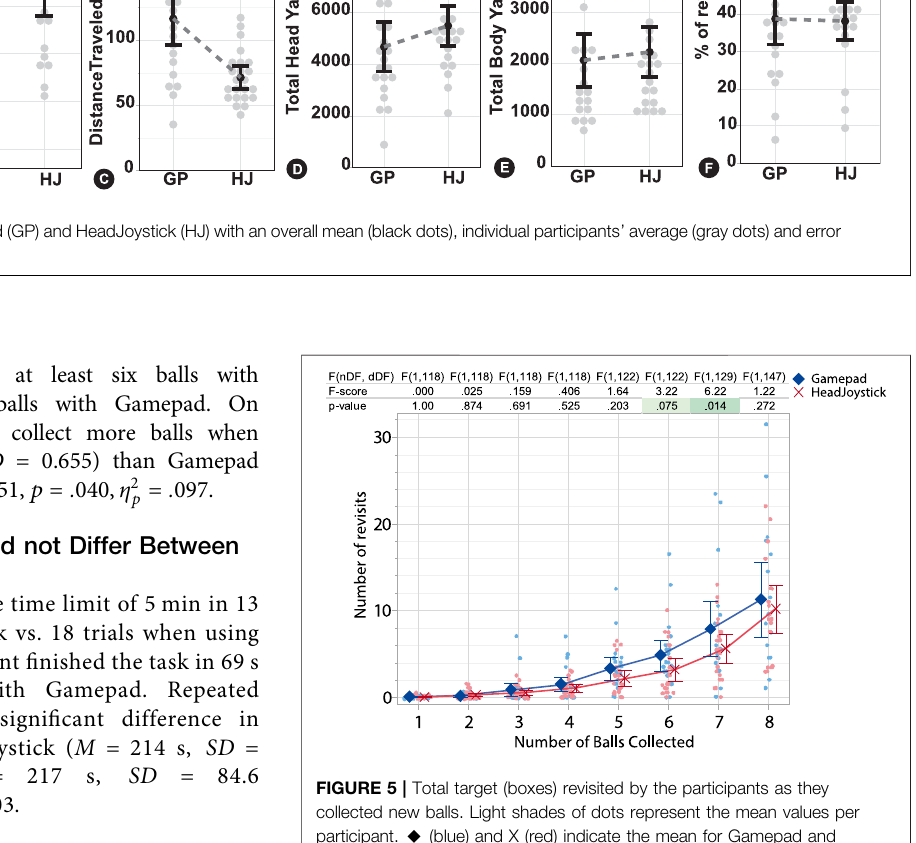
Figure 4C . Participants travelled from 33.5 to 143.9 m with HeadJoystick and from 30.8 to 277.4 m with Gamepad.